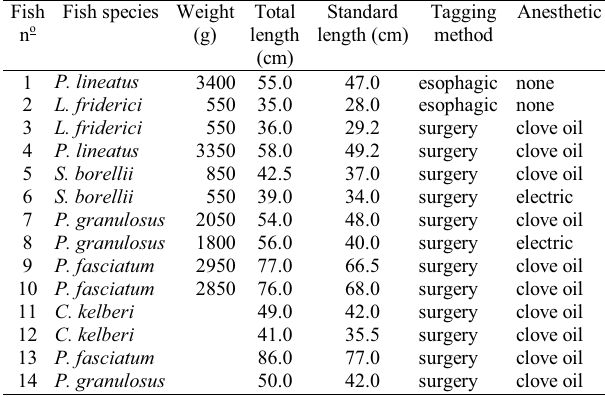
Table 1. Length, weight and tagging method for each radio- tagged